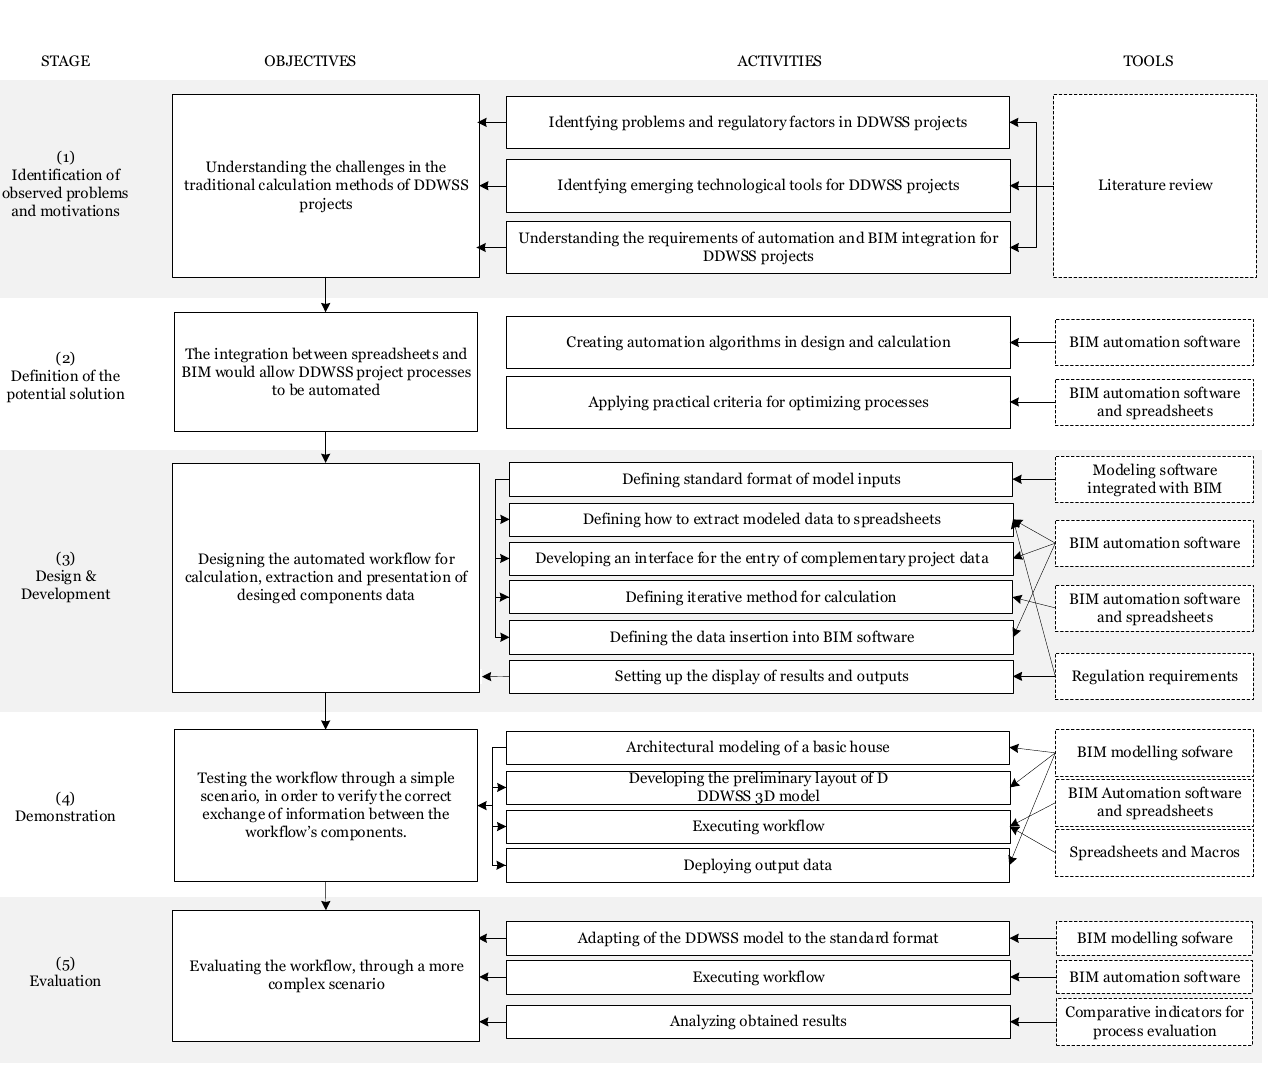
Figure 1. Research methodology workflow.